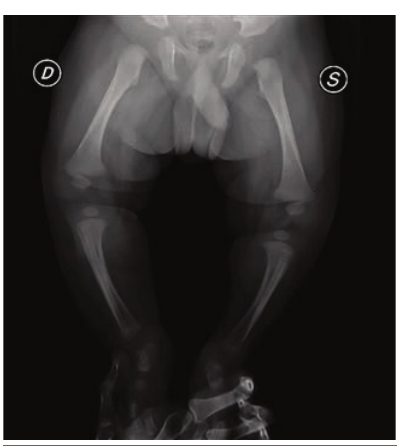
Figure 2. Lower limbs X-rays. No differ- ence in the shape and dimension of the bone can be